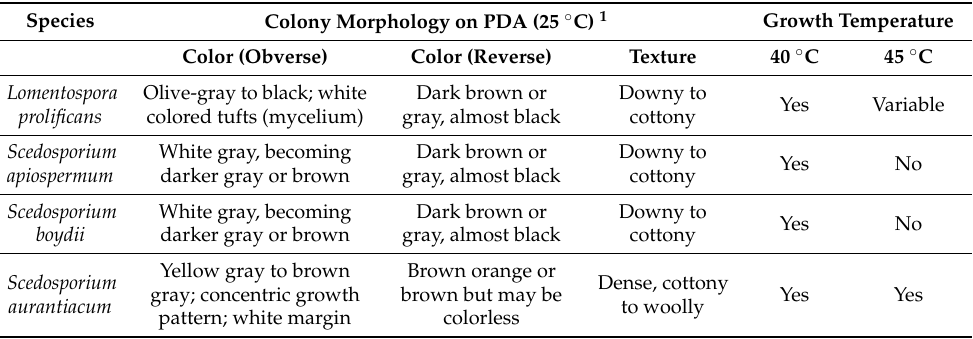
Figure 2. ( A ): Flat, spreading olive-grey to black colored and suede-like surface (obverse view) of Lomentospora prolificans on Sabouraud dextrose agar (SDA) after four days growth at 28 °C. ( B ): Greyish-white cottony to woolly surface with concentric growth pattern and white margins (obverse view) of Scedosporium aurantiacum on SDA after 3 days growth at 28 °C. ( C ): Brown orange center with pale yellow pigment (reverse view) of Scedosporium aurantiacum on potato dextrose agar after 3 days incubation at 28 °C. Table 1. Colony morphology, color, and growth characteristics of Scedosporium and Lomentospora prolificans on potato dextrose agar [11,28].